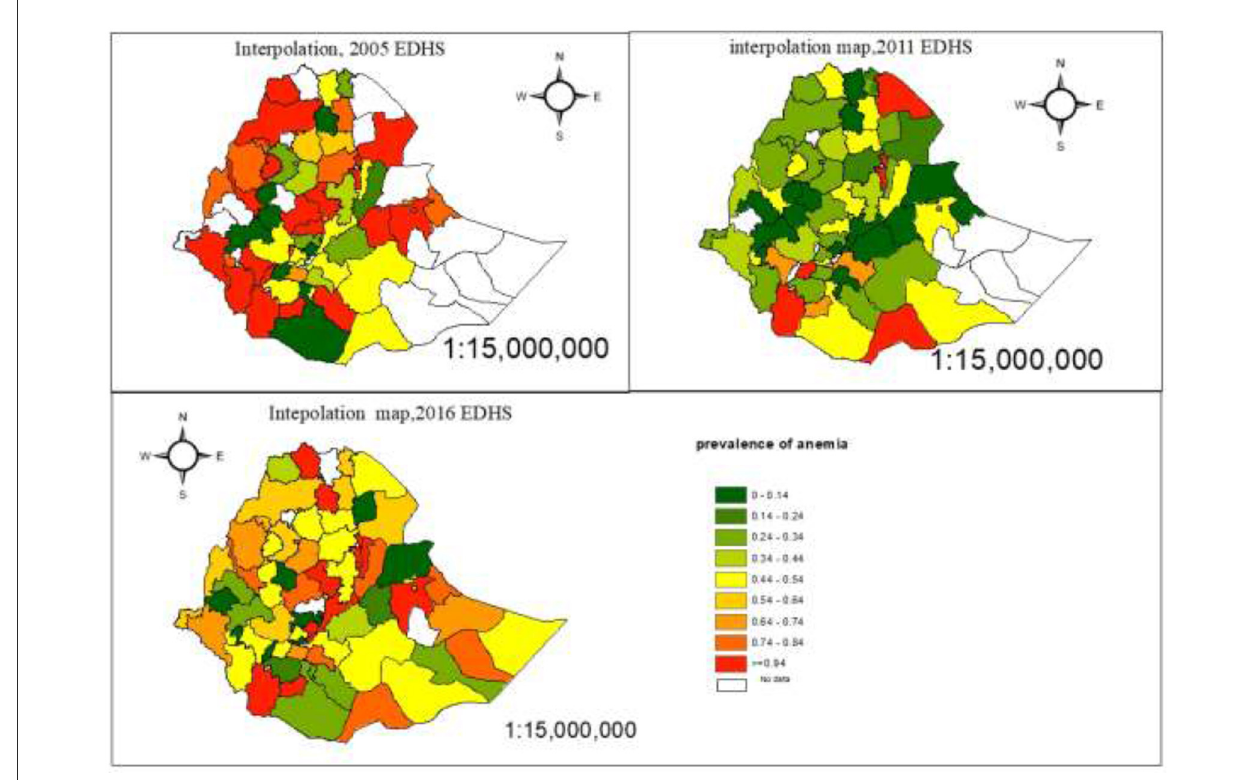
FIGURE6 The estimated prevalence of anemia among pregnant women in Ethiopian administrative